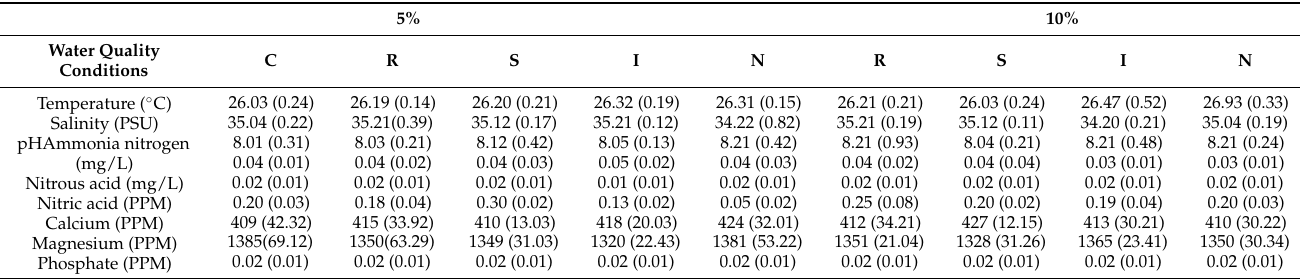
Table 2. Water quality